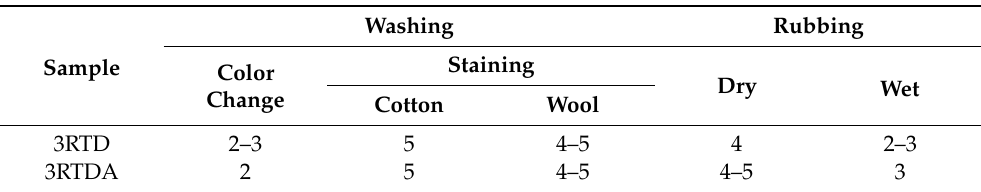
Table 14. Results of the washing and rubbing fastness tests of the samples dyed with common madder with or without rinsing.